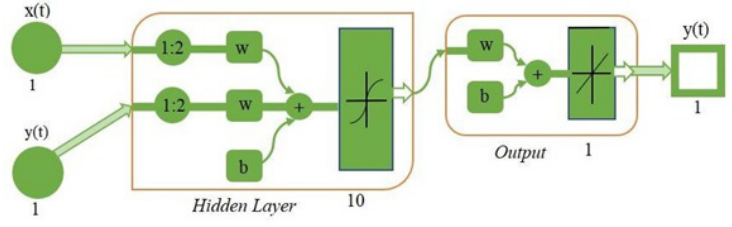
Figure 4. Architecture of artificial neural